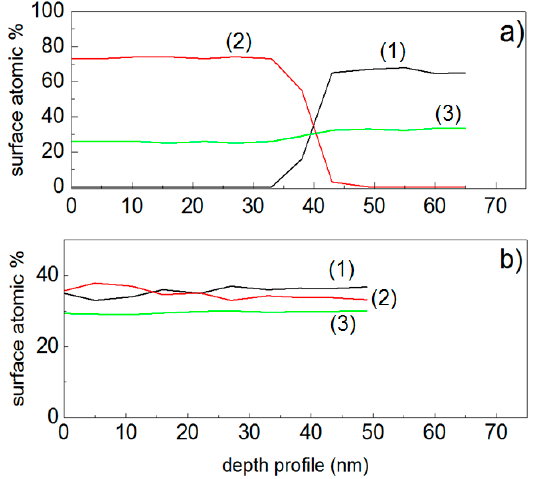
Figure 7. XPS etching by way of a beam of 5 kV Ar ion for: ( a ) sequentially sputtered TiO 2 /FeO x -PE films, (1) Ti2p, (2) Fe2p, and (3) O1s; ( b ) Co-sputtered TiO 2 –FeO x –PE films showing the atomic percentage concentration of atoms, (1) Ti2p, (2) Fe2p, and (3) O1s in the topmost layers (2 nm) as a function of the penetration depth. Reprinted from [54].